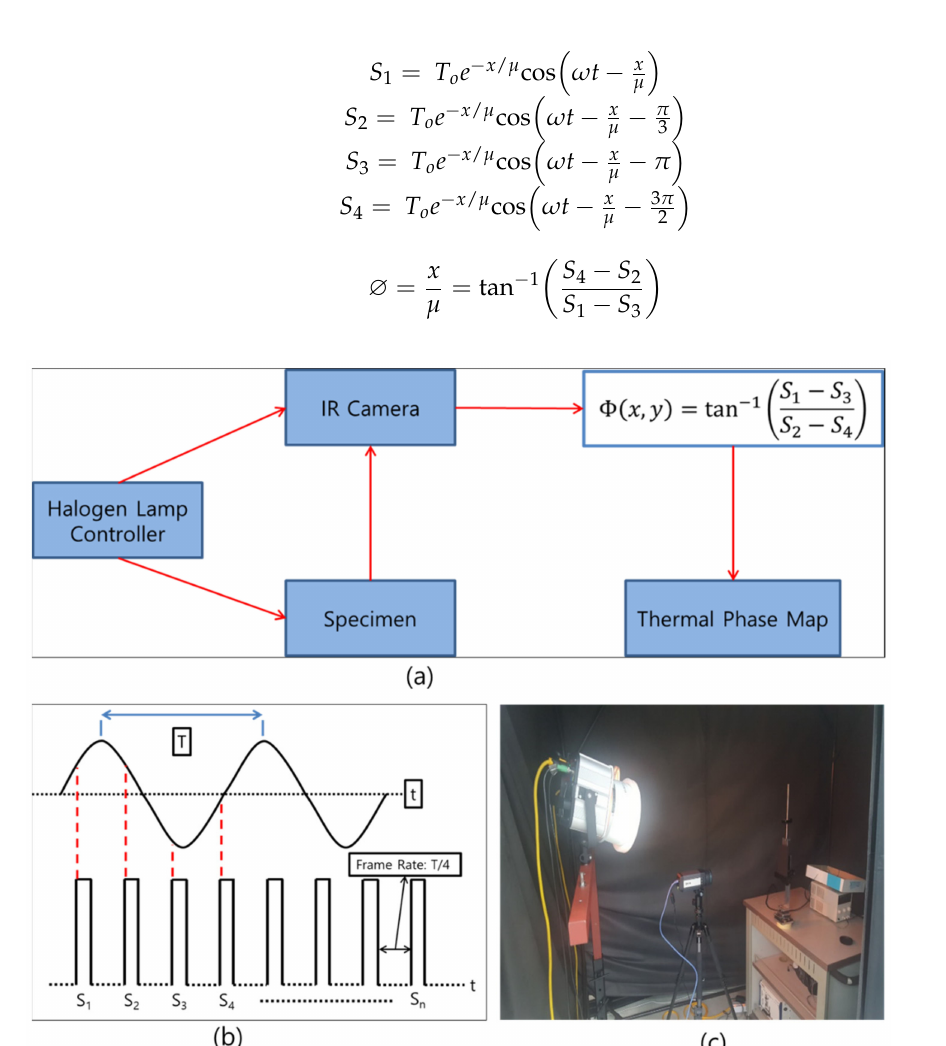
Figure 4. Lock-in method: ( a ) flowchart; ( b ) diagram and ( c ) experimental